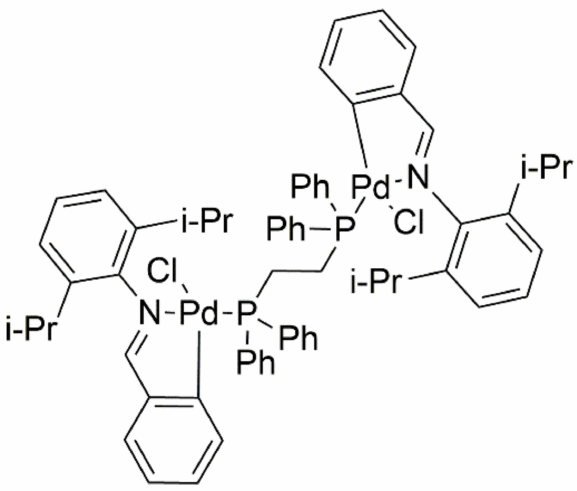
Figure 16. Complex AJ-5—binuclear palladacycle